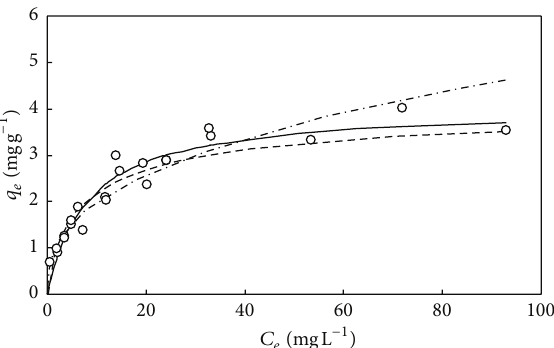
Figure 7: The simulations of Langmuir isotherm (—), Freundlich isotherm (- ⋅ -), and D-R isotherm (---) for adsorption of DMP on M-PVAL with pH 0 = 7. Final pH = 7.42–8.39. I : experimental data. −1 . 𝐶 𝐶 × , ∗ , and +: 𝑞 𝑒 versus 𝑒 with 0 = 9.55, 40.0, and 102.4 mgL